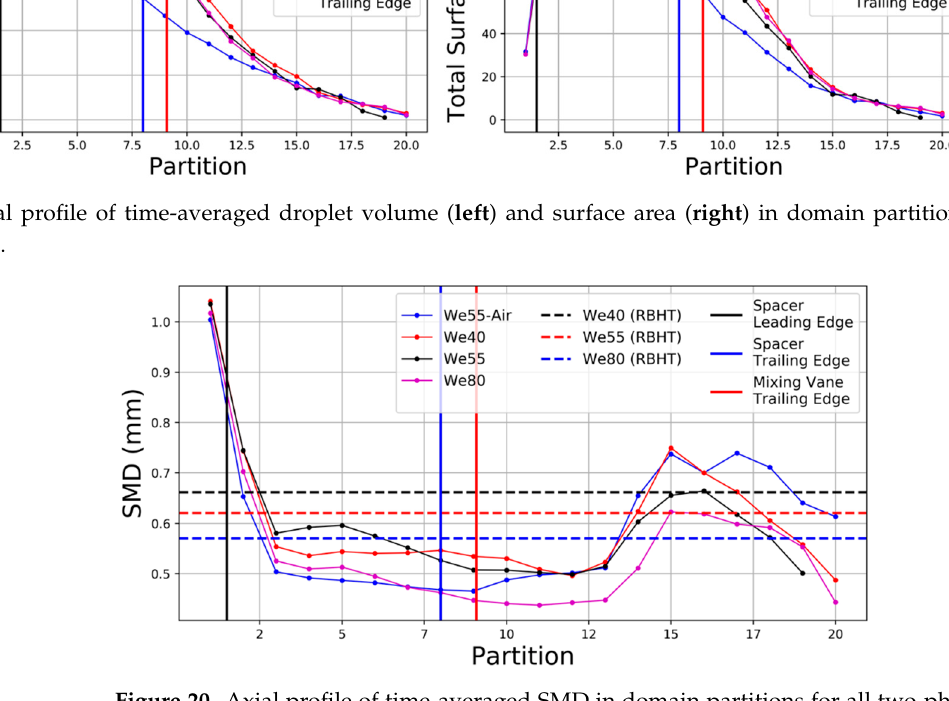
Figure 20. Axial profile of time-averaged SMD in domain partitions for all two-phase cases. The values obtained with the RBHT (rod bundle heat transfer) correlation by Cheung et al. [17] are also annotated.